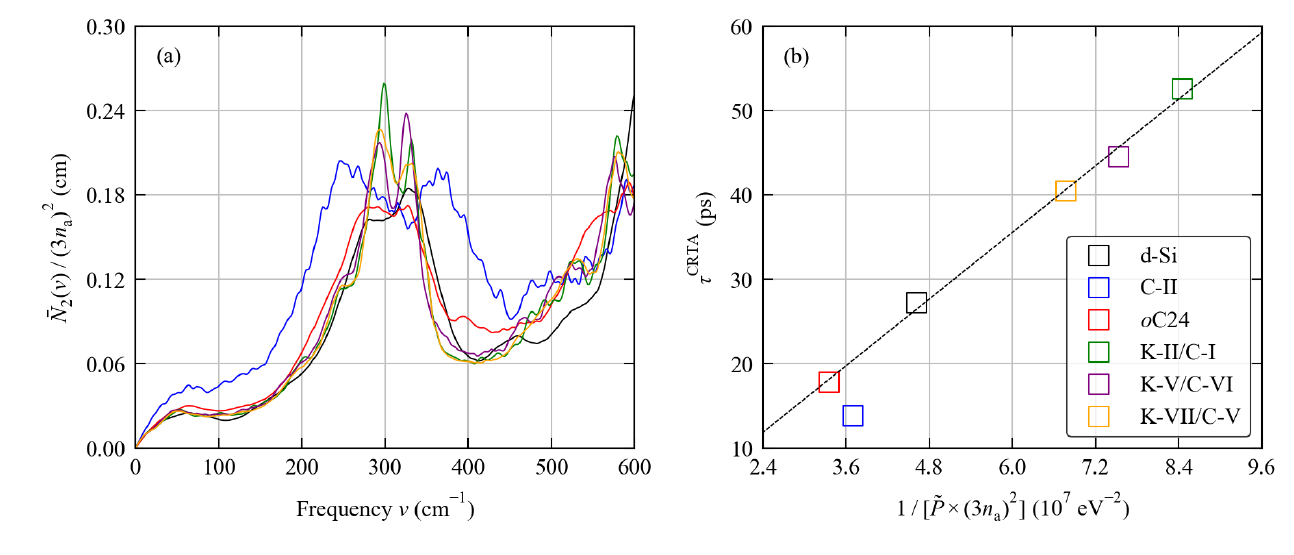
Figure 9. Analysis of the phonon lifetimes of the six systems examined in this work using the model defined in Equation (18) in the text. Plot ( a ) compares the scaled weighted two-phonon joint density of states (w-JDoS) functions ¯ N 2 ( ω ) at T = 300 K (Equation (22)). Plot ( b ) compares the averaged lifetimes τ CRTA defined in Equation (16) to the inverse averaged squared phonon-phonon interaction strengths 1/ ˜ P . The line colours used in Plot ( a ) match the marker colours in Plot ( b ). In Plot ( b ) the dashed black line is a linear fit to the data for d-Si and the o C24, K-II/C-I, K-V/C-VI and K-VII/C-V framework